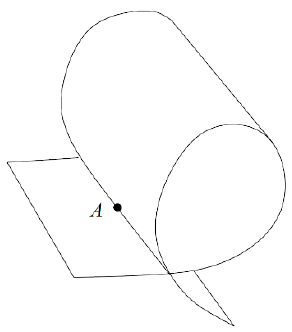
Figure 8. A surface with a self-intersection [26].